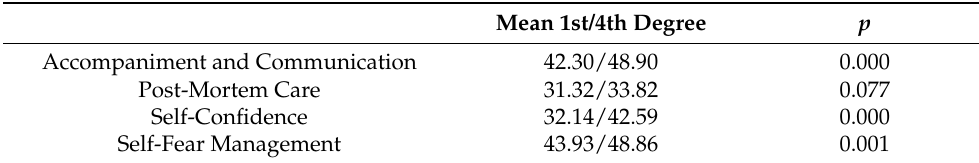
Table 4. Comparison per